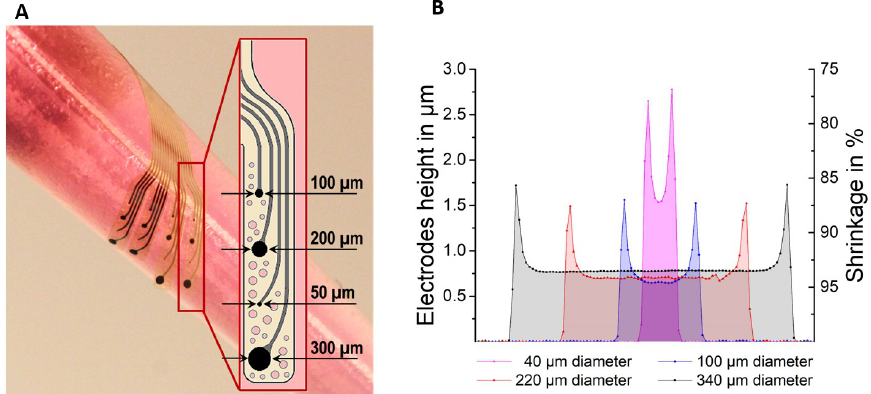
Figure 3. ( A ) Picture of an ECoG array after fabrication wrapped around a pipet with a diameter of about 8 mm. The inset shows one of the four PI ‘breathable’ or holed fingers with the different-diameter GC electrodes. ( B ) Profilometer data showing shape, height of GC electrodes (primary Y-axis) and vertical shrinkage in percentage (secondary Y-axis) of 40, 100, 220 and 340 µ m diameter SU-8 structures after pyrolysis (1000 ◦ C, in N 2 ). The height of all the structures before pyrolysis was 13 µ m. N = 5 samples per